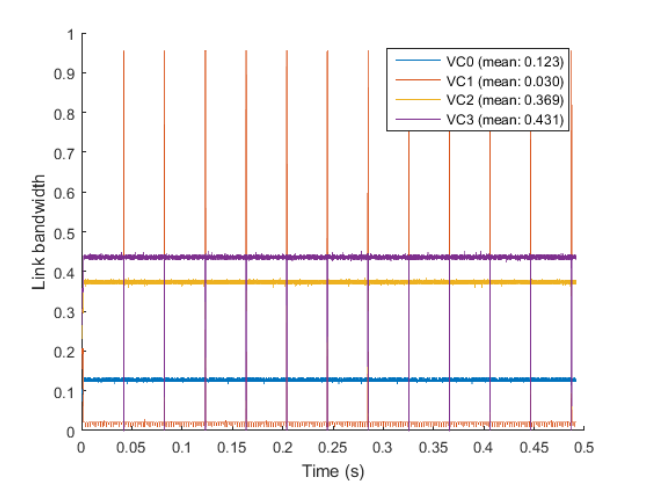
Figure 11. Link utilization per Virtual Channel of the Routing Switch SpaceFibre output